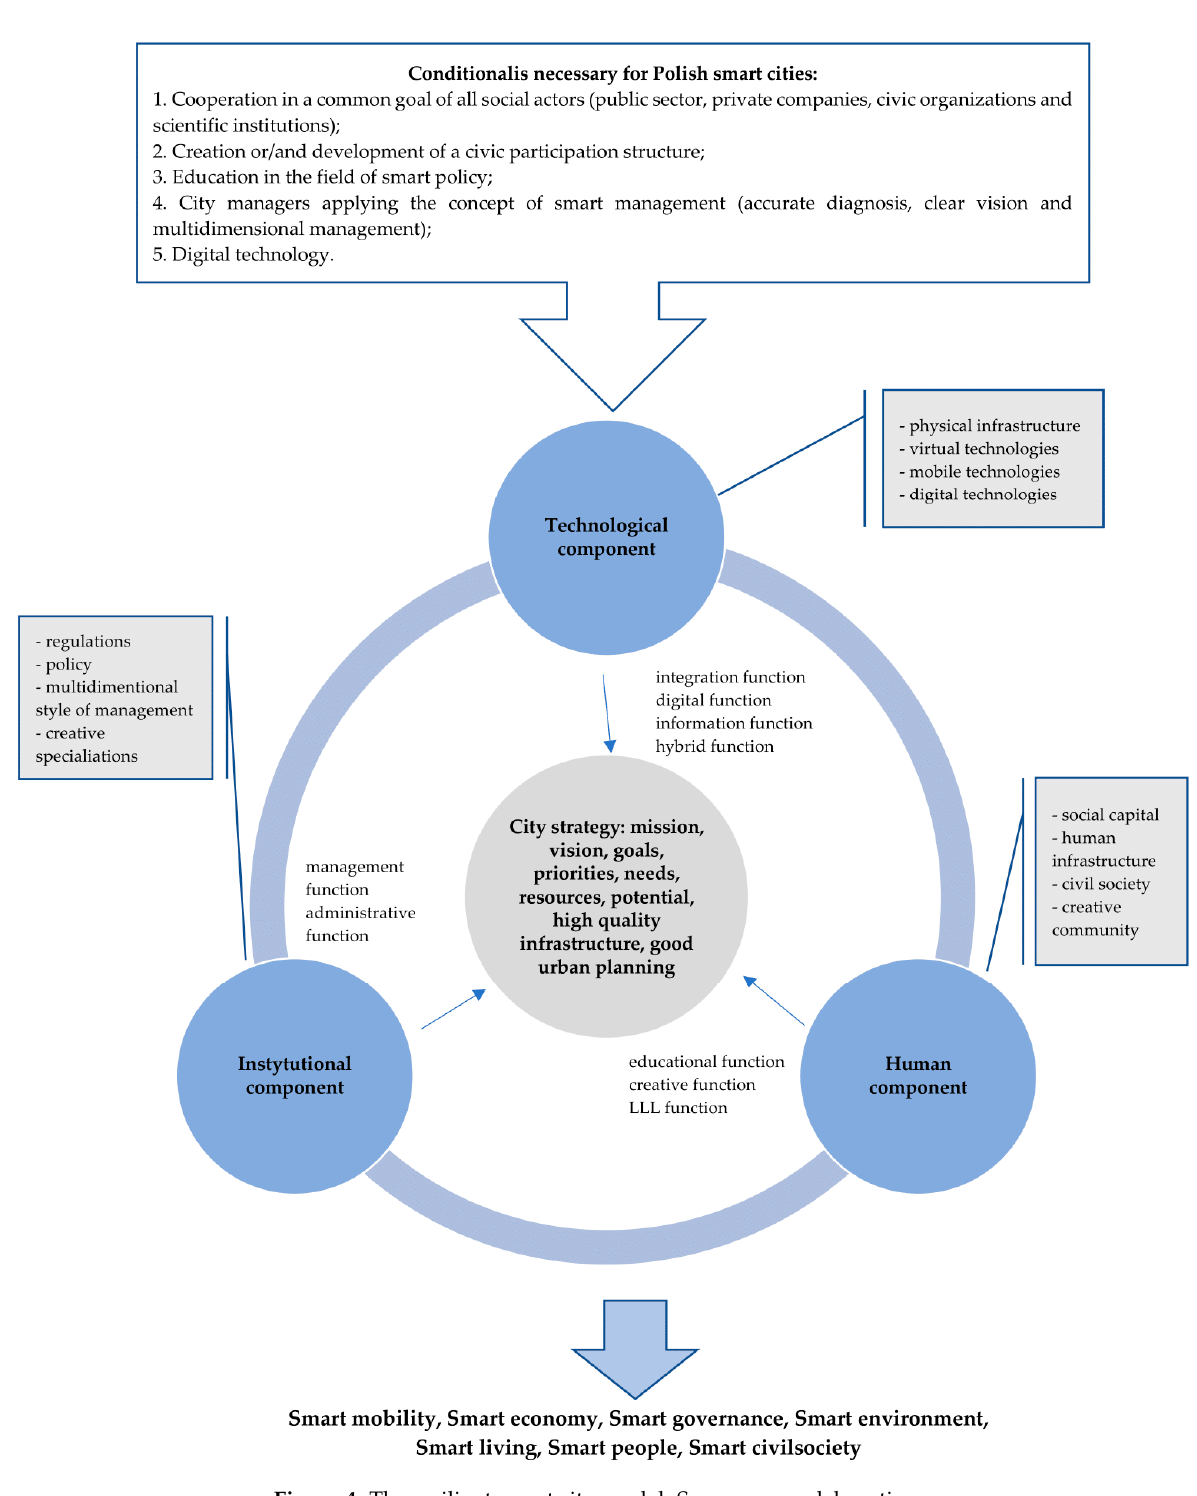
Figure 4. The resilient smart city model. Source: own elaboration.